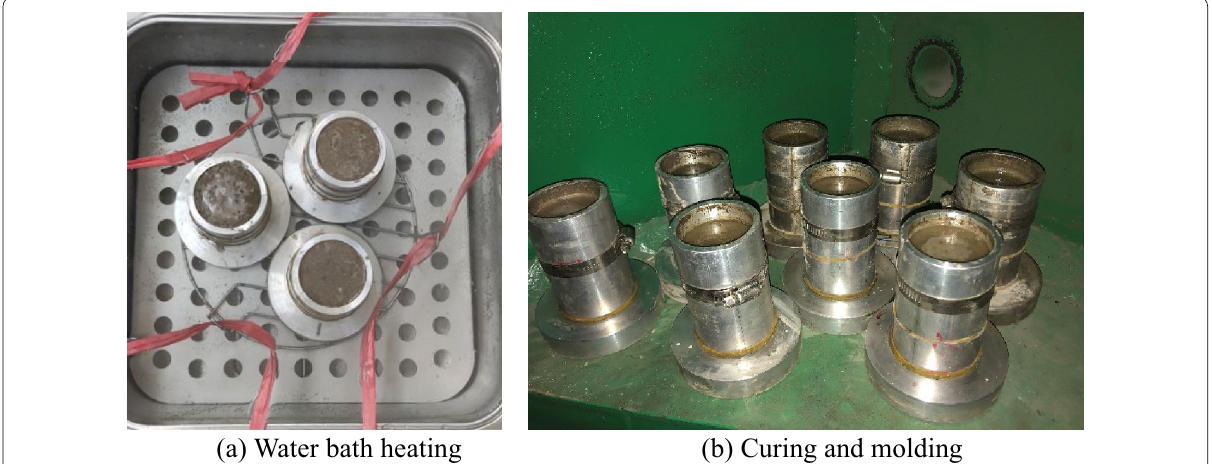
Fig. 4 Preparation of PCL‑cement paste samples.